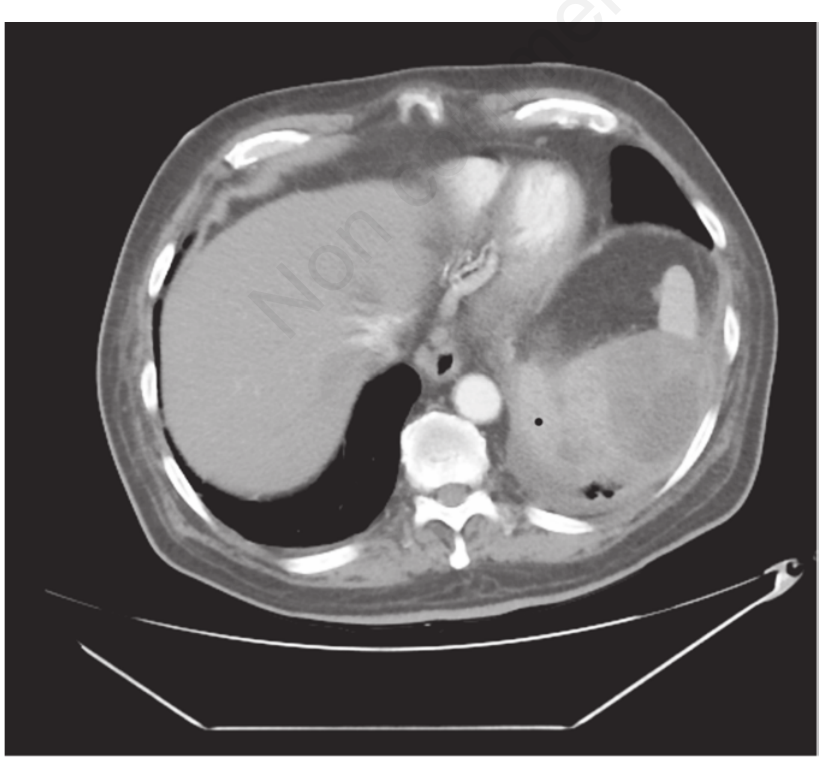
Figure 1. Multiple splenic hypodensities seen on computed tomography